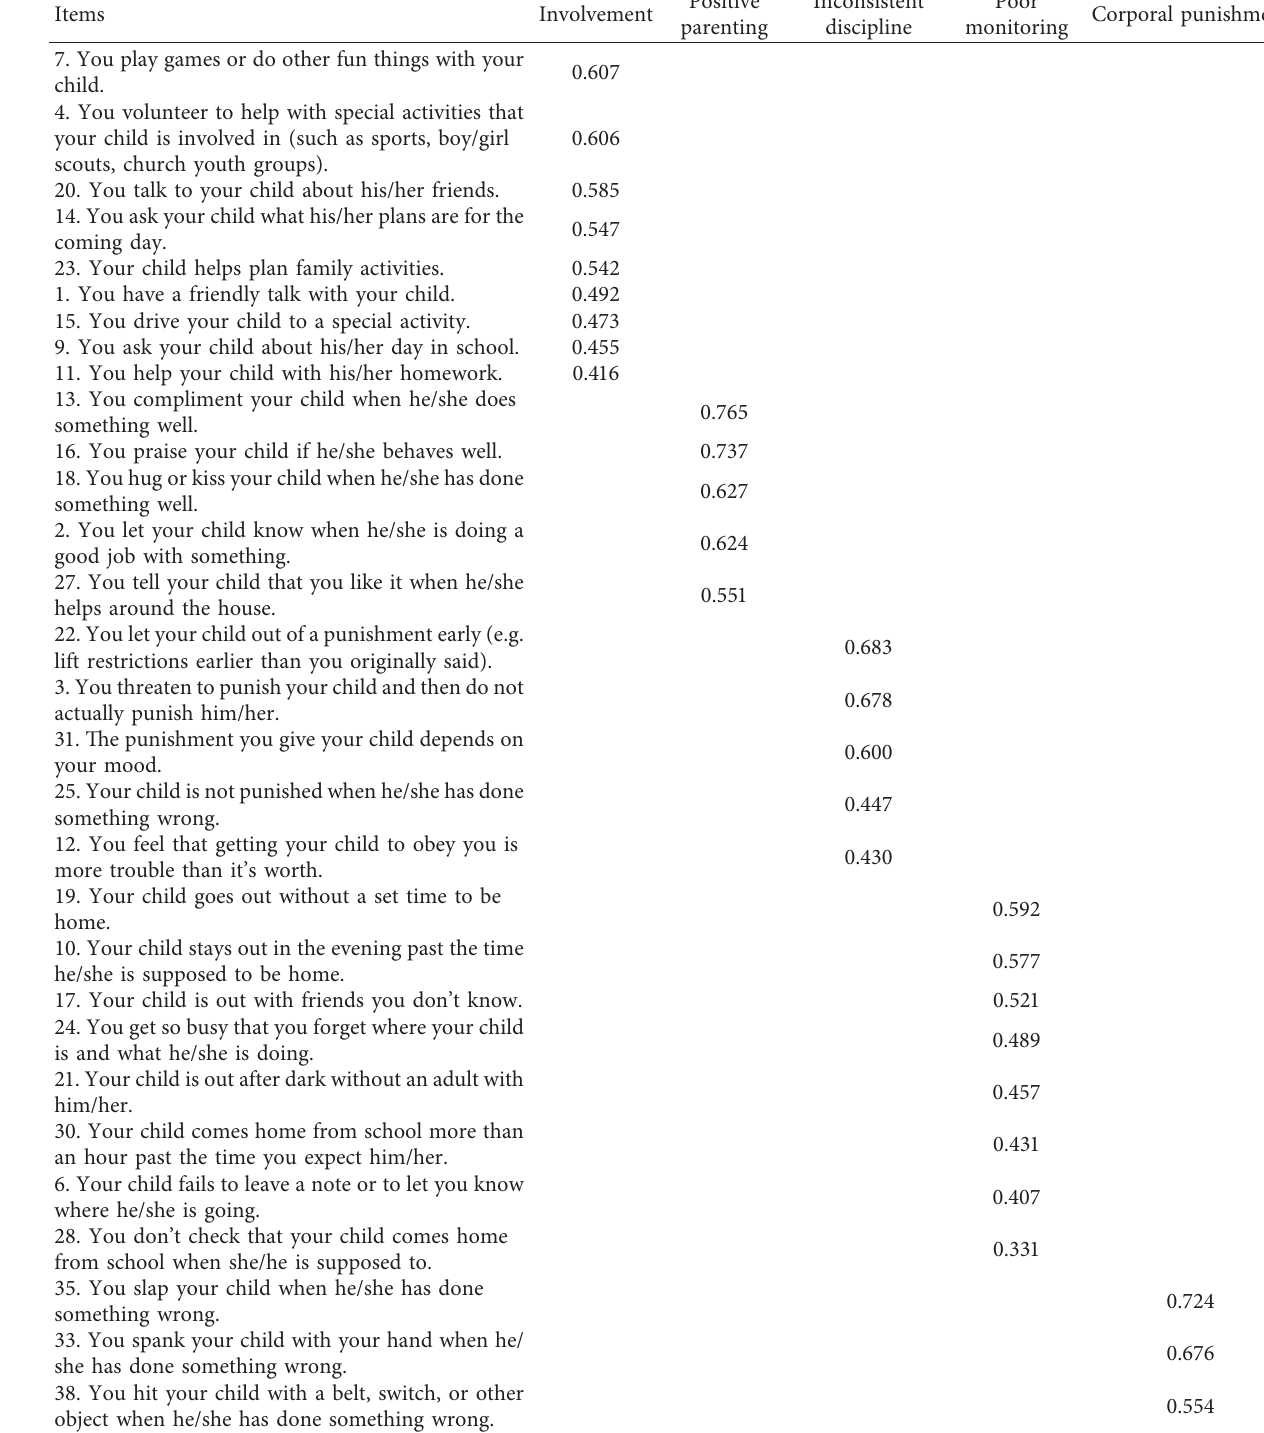
Table 1: Load factors of